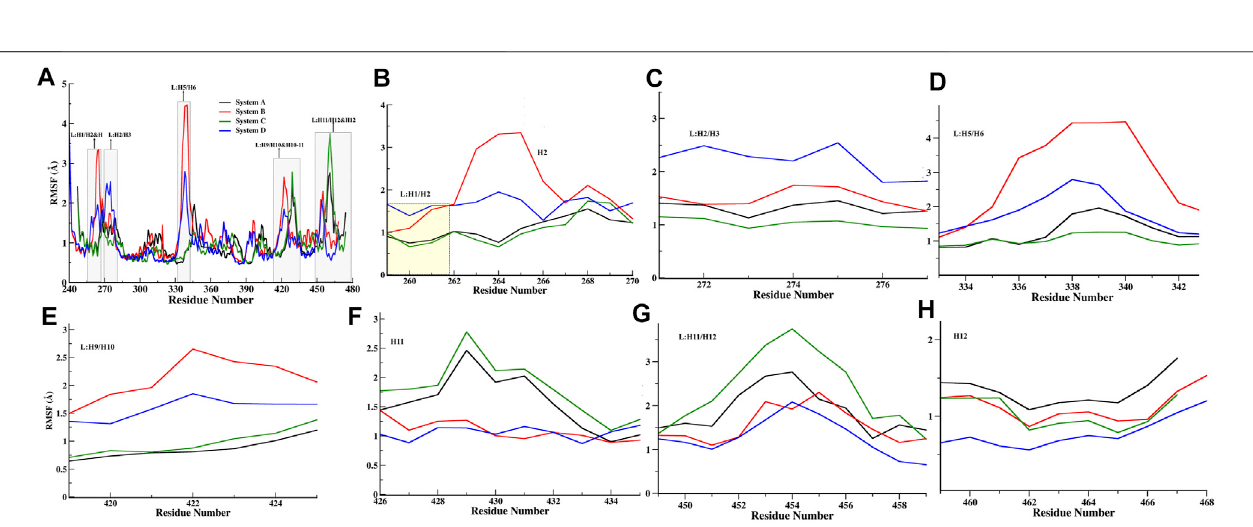
Frontiers in Molecular Biosciences |